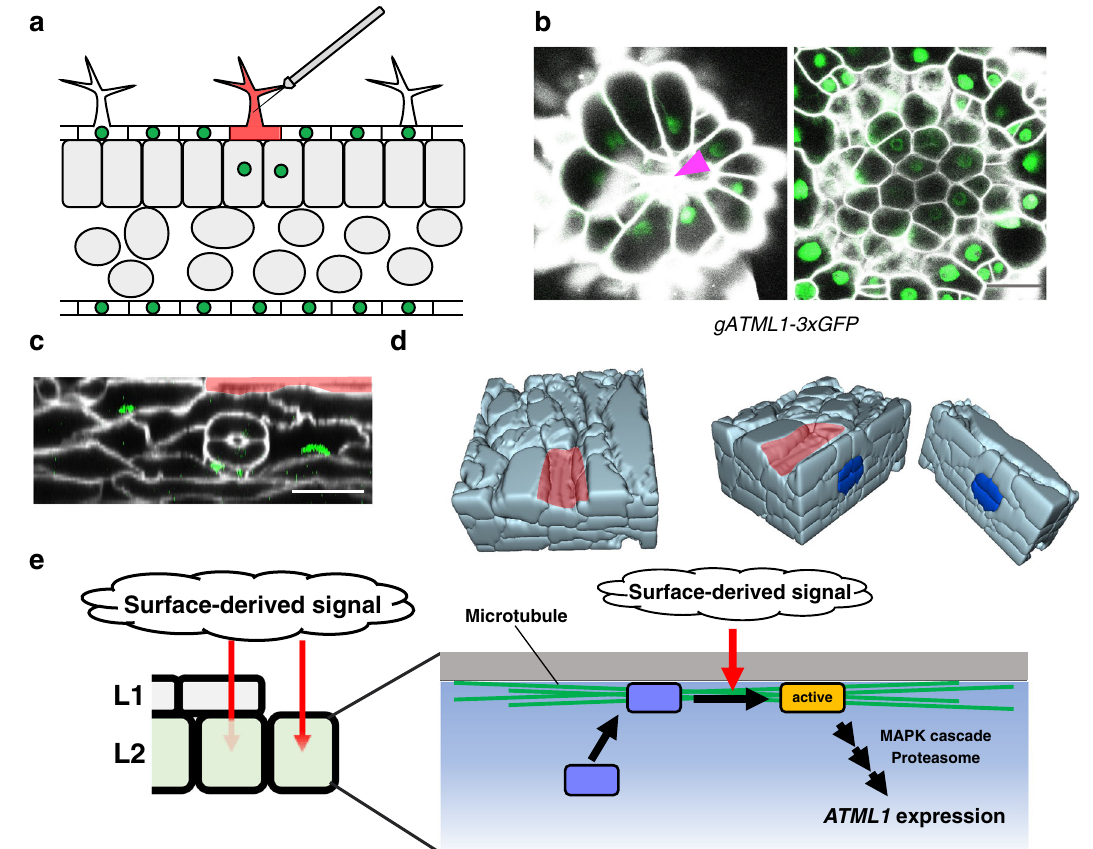
Fig. 5 | The epidermis was regenerated from mesophyll cells after outer tissue injury. a Schematic drawing of a transverse leaf section showing trichome injury. b ATML1 protein accumulation in mesophyll cells beneath the killed trichomes. After trichomes of the fi rst or second leaves in 6-day-old gATML1-3xGFP seedlings weredamagedwithaneedle,theseedlingsweregrownfor24h.Left,leafepidermis withakilledtrichome(arrowhead);right,mesophyllcellsbeneaththeepidermisof the same leaf as in the left panel. c , d Stomata formation from the inner lineage tissues of the leaves after outer tissue injury. After the outer tissues of leaves in 6- day-old proATML1-nls-3xGFP seedlings were damaged with a needle, the seedlings weregrownfor fi vedays. c showsanopticaltransversesectionoftheleaf.Notethat inner guard cells and their surrounding cells expressed the proATML1-nls-3xGFP marker. In d the mesophyll-derived inner stoma in c is shown in 3D